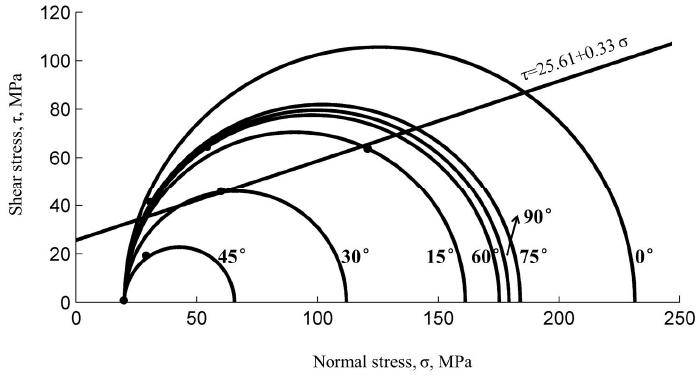
Figure 11. Mohr circles at failure for a typical run of Longmaxi shale with the criterion for failure in the plane of bedding.